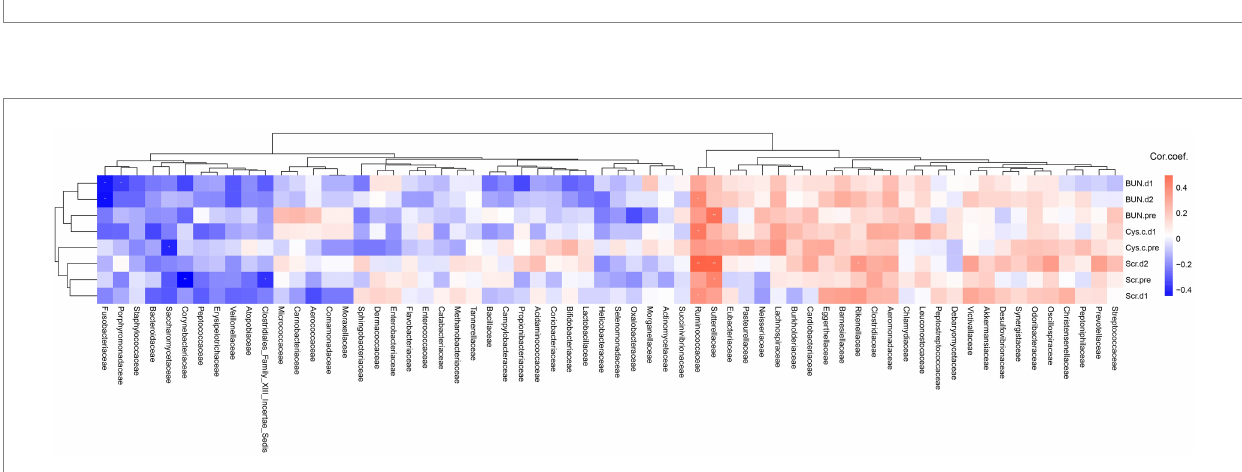
FIGURE 7 Heatmap showing the association between the eight clinical renal functional variables and family abundance in the gut microbiome of CSA-AKI patients. Single asterisks indicate statistical significance based on Spearman correlation with p < 0.05, and double asterisks indicate statistical significance with p < 0.01. Cor. coef., correlation coefficient; BUN-pre, preoperative blood urea nitrogen; BUN-d1, blood urea nitrogen on postoperative day 1; BUN-d2, blood urea nitrogen on postoperative day 2; Scr-pre, preoperative blood urea nitrogen; Scr-d1, blood urea nitrogen on postoperative day 1; Scr-d2, blood urea nitrogen on postoperative day 2; Cys C-pre, preoperative blood urea nitrogen; Cys C-d1, blood urea nitrogen on postoperative day